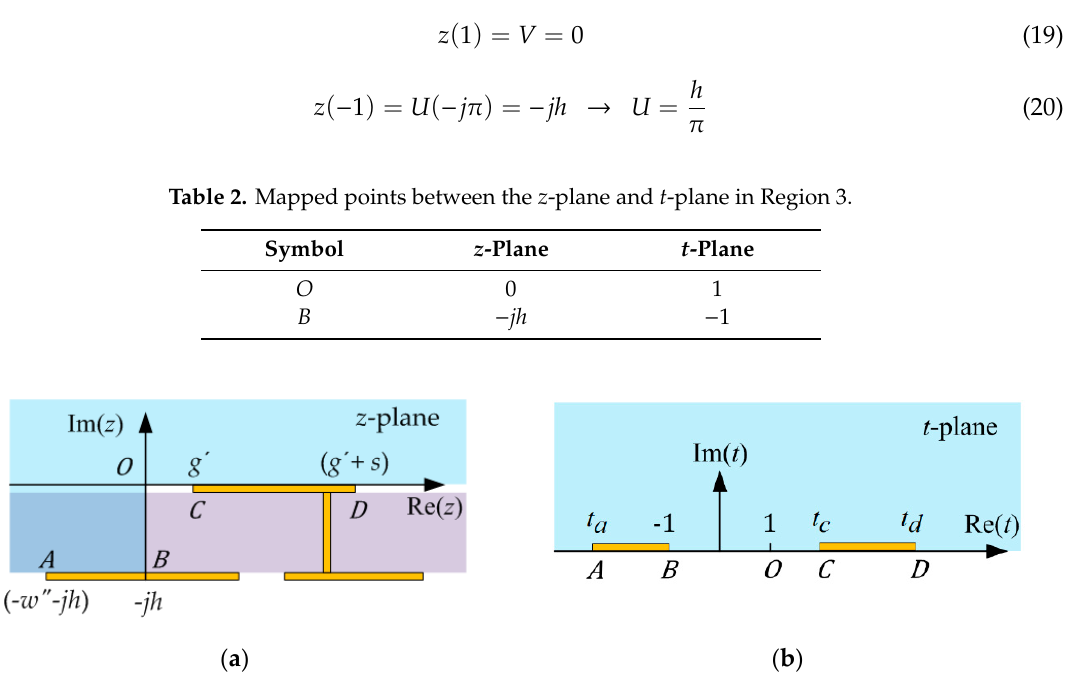
Figure 7. Conformal mapping of Region 3: ( a ) z -plane, ( b ) t -plane.